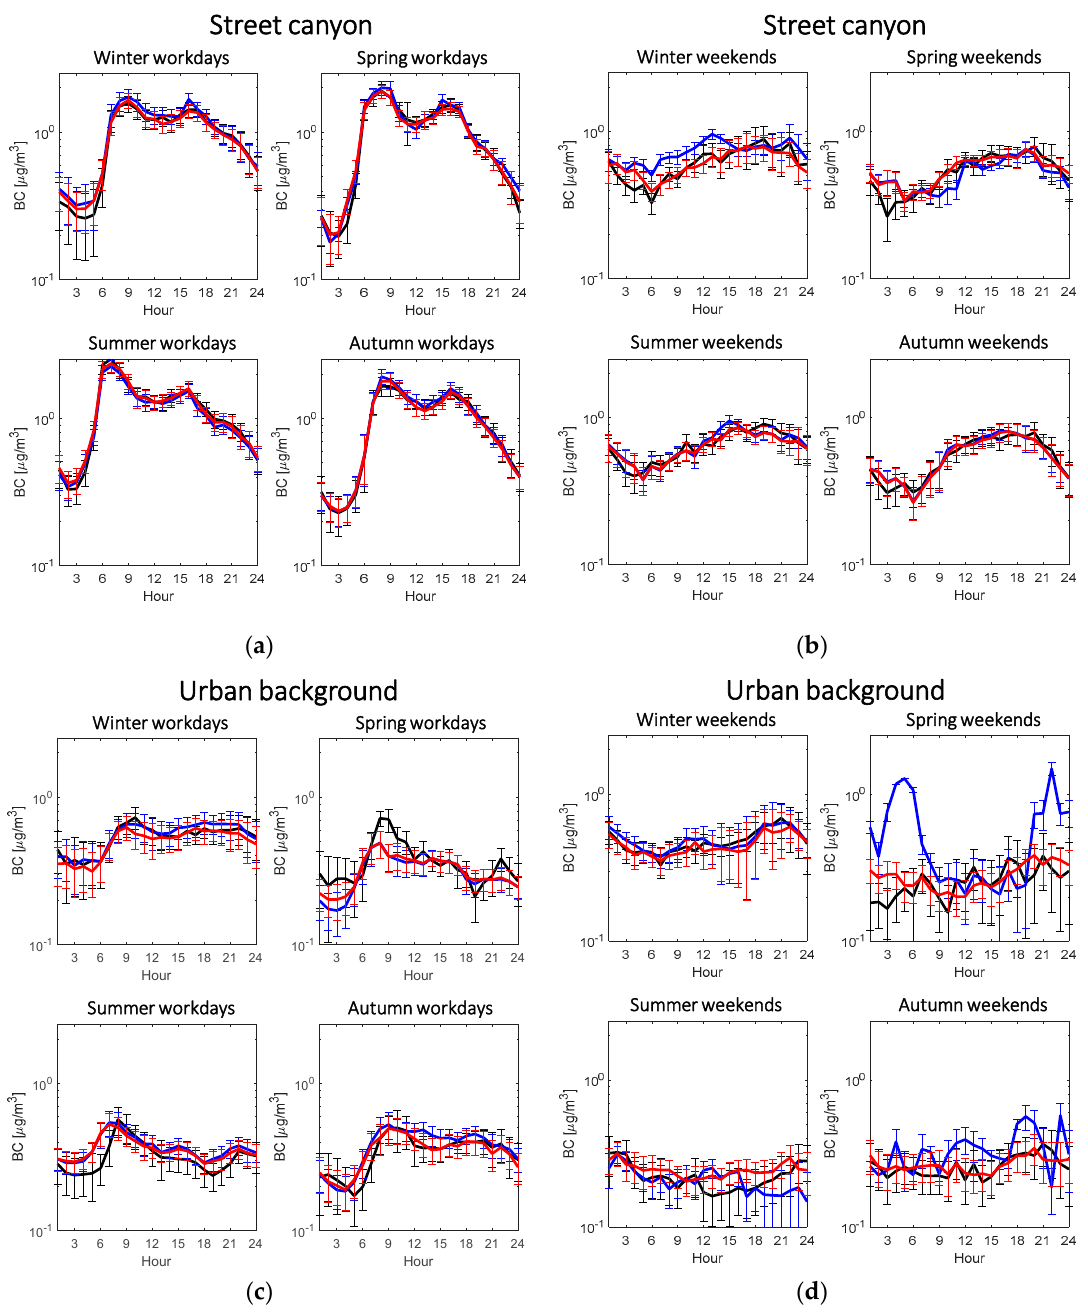
Figure 8. Four diurnal subplots of original measured BC (black line), BC calculated by traditional proxy (blue line) and BC calculated by input-adaptive proxy (red line). ( a ) and ( b ) show diurnal pattern in the street canyon in Mäkelänkatu on workdays and on weekends, respectively. ( c ) and ( d ) show diurnal pattern in the urban background station in Kumpula on workdays and on weekends, respectively. Error bars are shown as standard deviation at each hour of the day.